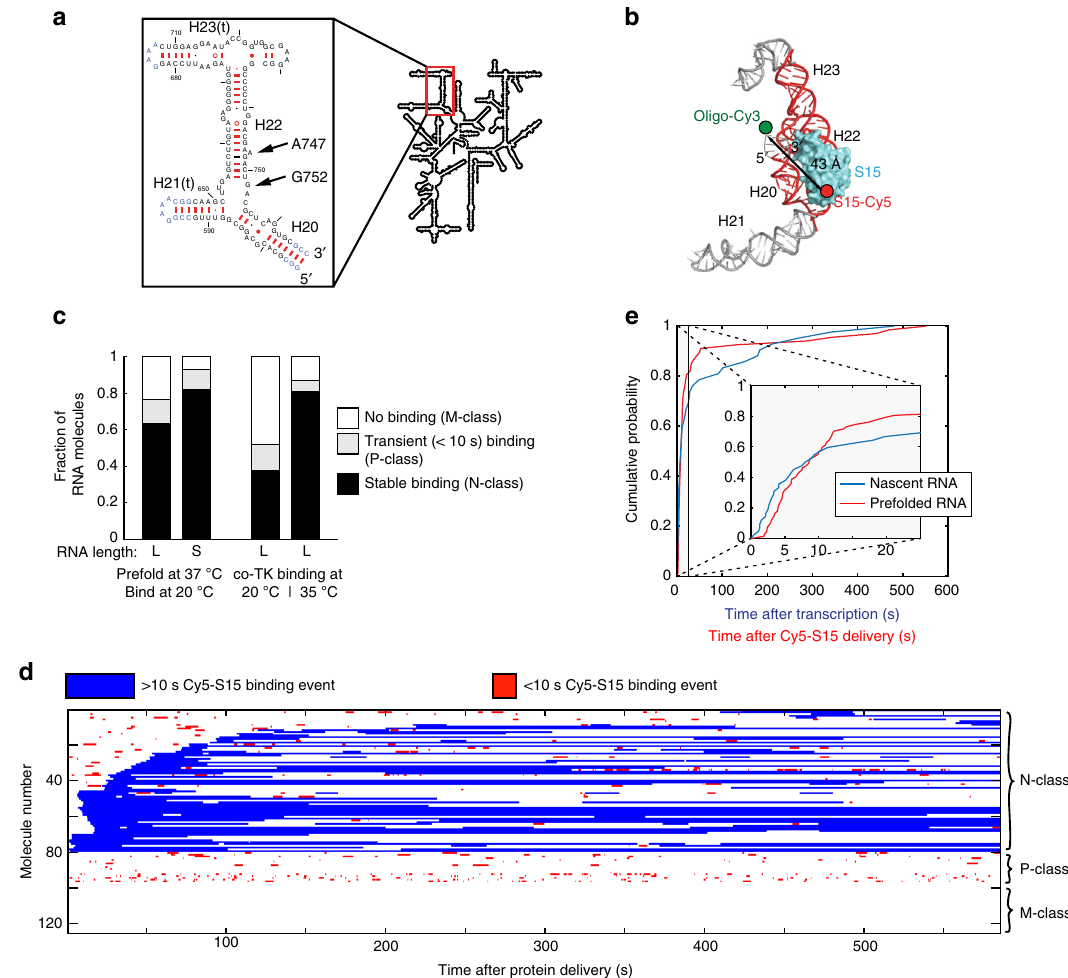
Fig. 5 Comparing S15 binding to pre-folded versus nascent RNA. a RNA construct used to observe S15 binding: It constitutes part of the central domain of the 16 S rRNA. H21(t) and H23(t) denote truncated helices compared to wild-type. RNA mutants used in this study are depicted. b Cy5-labeled r-protein S15 bound to the 16 S rRNA of the E. coli 30 S ribosomal subunit (PDB accession code: 4V9P); the Cy5 dye of the protein and the Cy3 dye of the labeled DNA oligonucleotide bound to the 3 ’ -end of the nascent RNA are modeled into the structure. c Partitioning of the RNA molecules into three folding classes for pre-folded compared to nascently transcribed RNA. N-class: natively folded RNA; P-class: partially folded; M-class: misfolded. L is 171 nt and S denotes 85 nt construct (see Supplementary Methods). Number of molecules analyzed ( n ) = 125, 65, 168, 172 from left to right. d Timing of S15 binding events in a stack of single-molecule traces, where 5 nM Cy5-S15 protein was delivered at t = 0 s to a pre-folded, immobilized RNA. Traces were clustered by lifetime and initial onset of stable (>10 s) S15 binding events and the total number of events per trace, resulting in three RNA folding classes. Each row represents the trace resulting from a single pre-folded RNA molecule. e Time of fi rst stable S15 binding event after delivery of 25 nM Cy5-S15 protein to a pre-folded RNA (red) or after transcription of a nascent RNA (blue), respectively. For nascent RNA binding, the experimental scheme in Fig. 6a was used. Number of molecules analyzed ( n ) = 67 and 42 for pre-folded or nascent RNA, respectively. Source data are provided as a Source Data fi